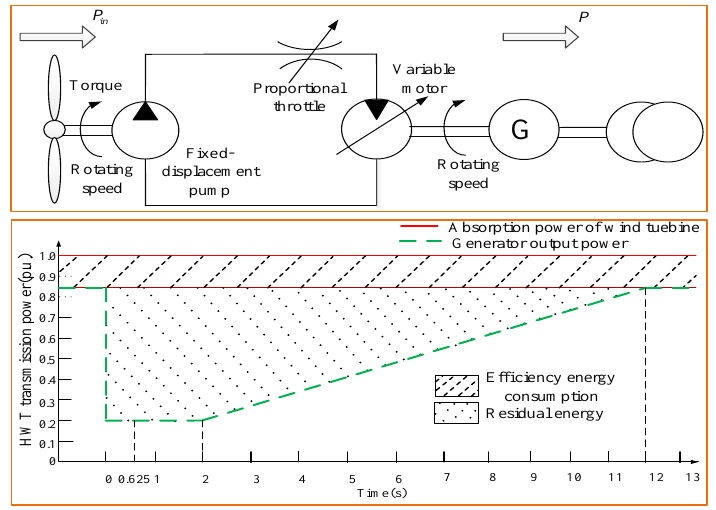
Figure 3. Low voltage ride-through (LVRT) energy flow diagram.